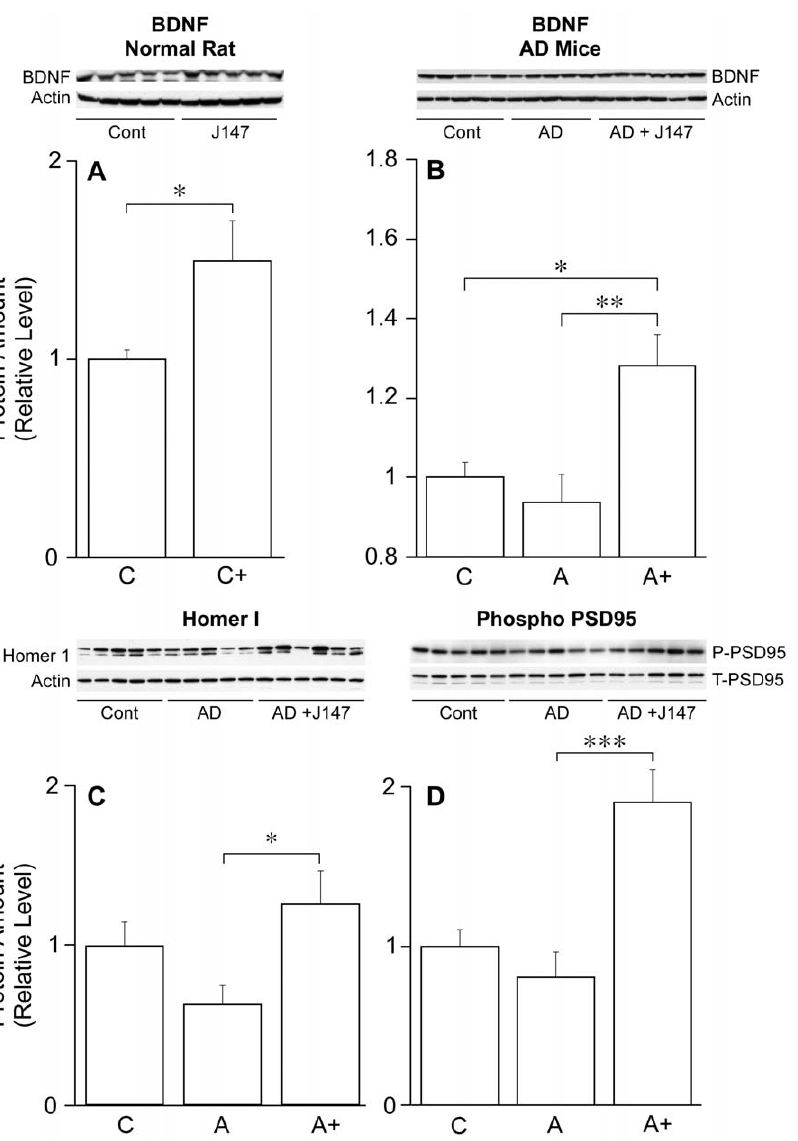
Figure 9. J147 Increases the Levels of BDNF and BDNF Responsive Protein and Protein Phosphorylation. (A) BDNF expression in the hippocampus of normal adult rats following two weeks treatment of J147 in food at 200 ppm. J147 treatment increased BDNF levels in the normal rat. Two-tailed t test. * P , 0.05. (B) BDNF expression in hippocampus of huAPP/PS1 transgenic mice fed J147 for 7 months before sacrifice at 10 months. BDNF levels are decreased in AD transgenic mice and treatment with J147 restores levels to beyond control levels. (C) Homer-1 expression in huAPP/PS1 mice. J147 treatment increases Homer-1 levels. (D) Phosphorylation of PSD95 at Tyr 236, 240. J147 treatment increases phosphorylation of PSD95 in AD transgenic mice. Data are presented as ratio of phospho PSD95 to total PSD95. * P , 0.05, ** P , 0.01, and *** P , 0.001. All data shown are means 6 SEM. n=5–6 per group. C=control; C + =control + J147; A=AD transgenic; A + =AD transgenic fed J147.